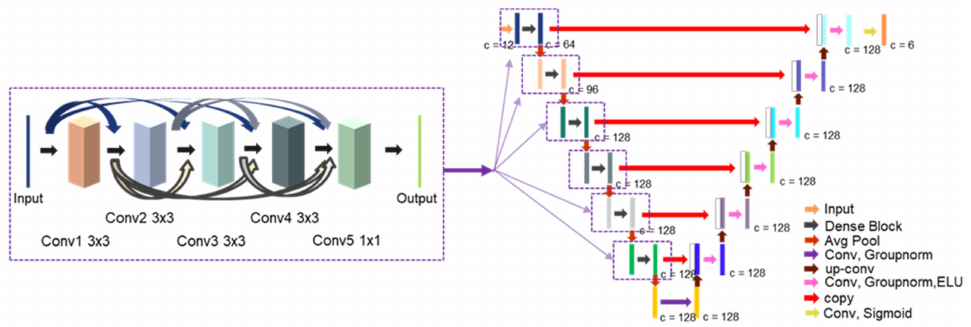
Figure 2. Dense-UNet architecture (purple box is a dense block and consists of densely connected convolution layers; at each level, the channel of the feature map is indicated by